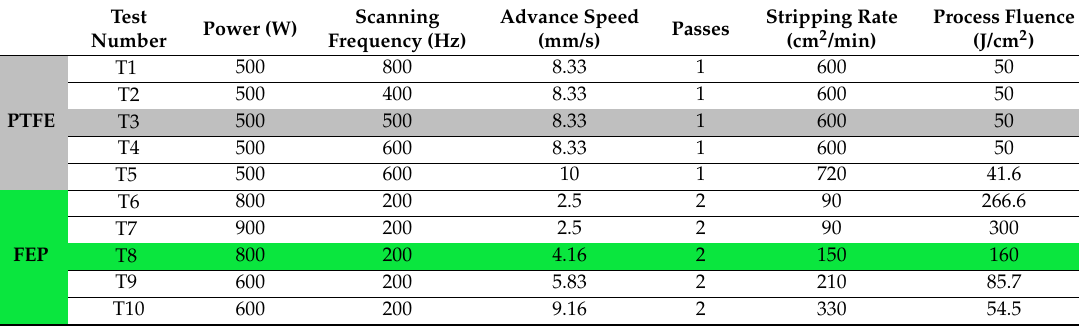
Table 4. Parameters selection tests for the Nd:YAG (CW) 2200W laser stripping of non-stick coatings (grey: final conditions selection for PTFE; green: final condition selection for FEP). Test Scanning Power (W) Number Frequency